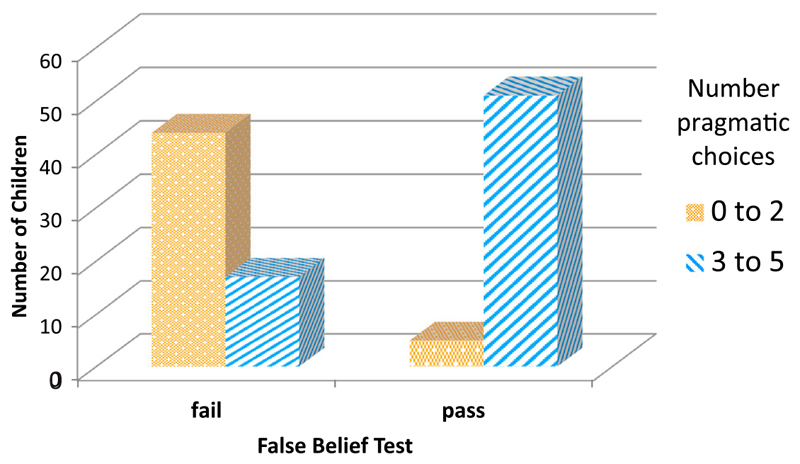
Number of children with a majority of pragmatically adequate choices overcoming the mutual exclusivity bias. Data from Gollek and Doherty (2016, Experiments 2 and 3).